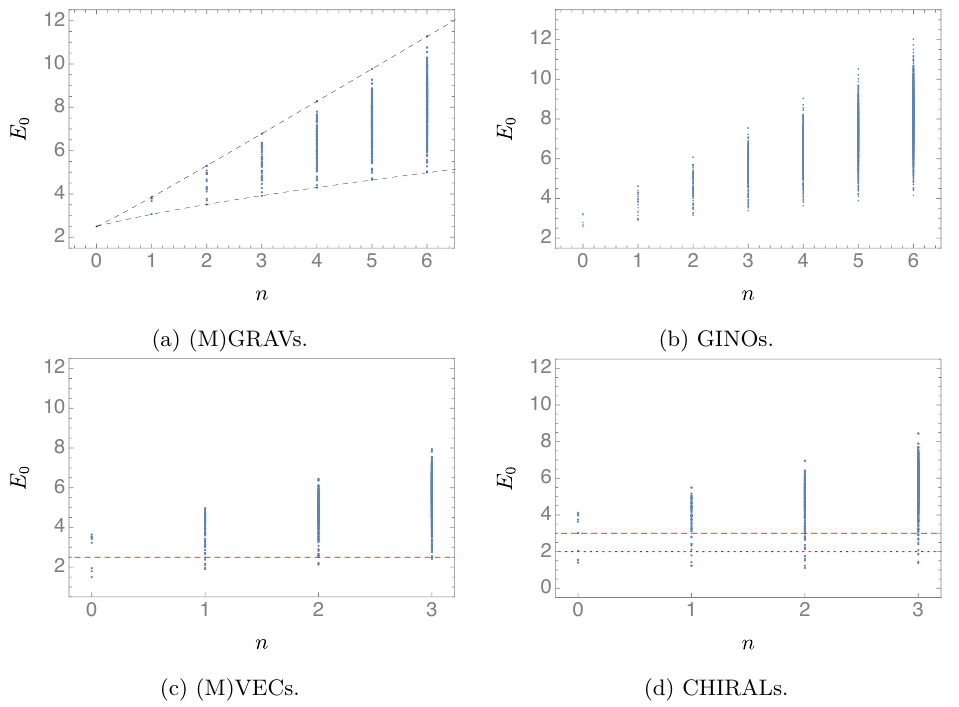
Figure 2 . Dimensions E 0 of all four types of OSp (4 | 1) multiplets present in the spectrum of the type IIA U(1)-invariant solution with cosmological constant g − 2 c 1 3 V = − 35 . 610235 , at first few KK levels n